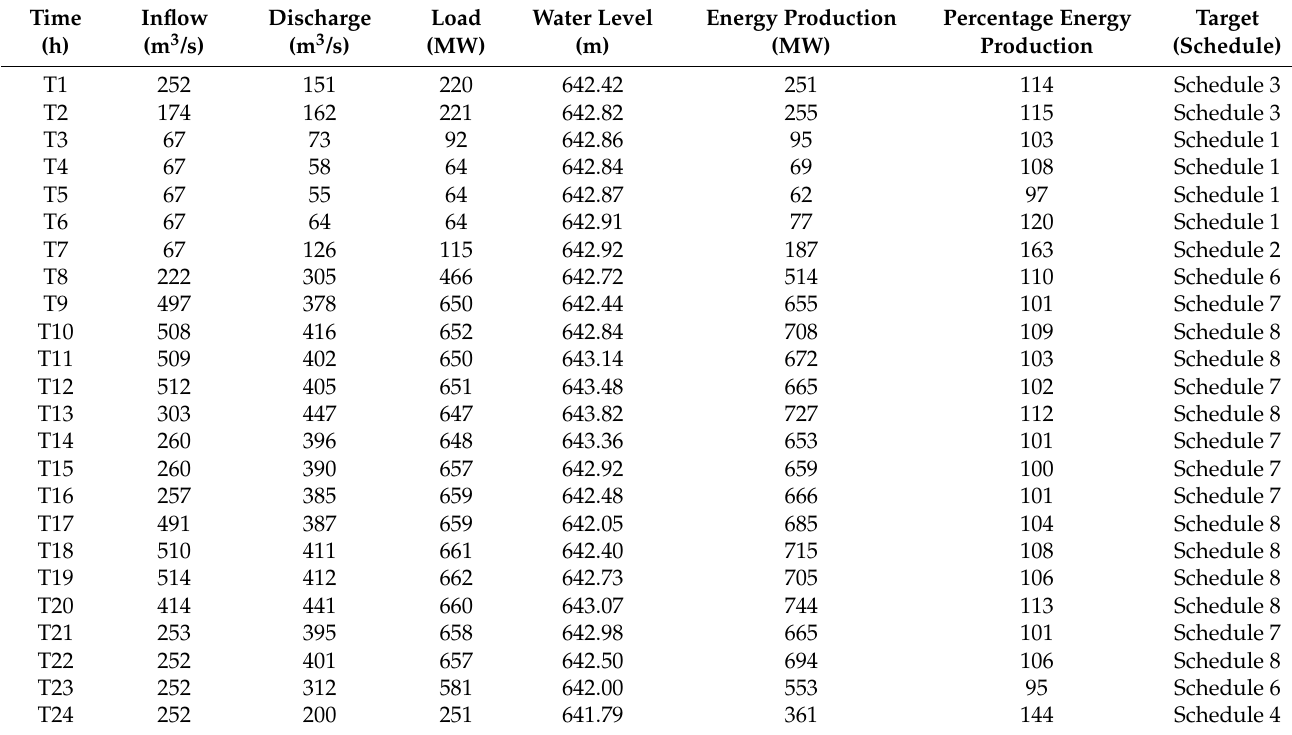
Table 3. Data set of Tianshengqiao plant 2 for the winter season.